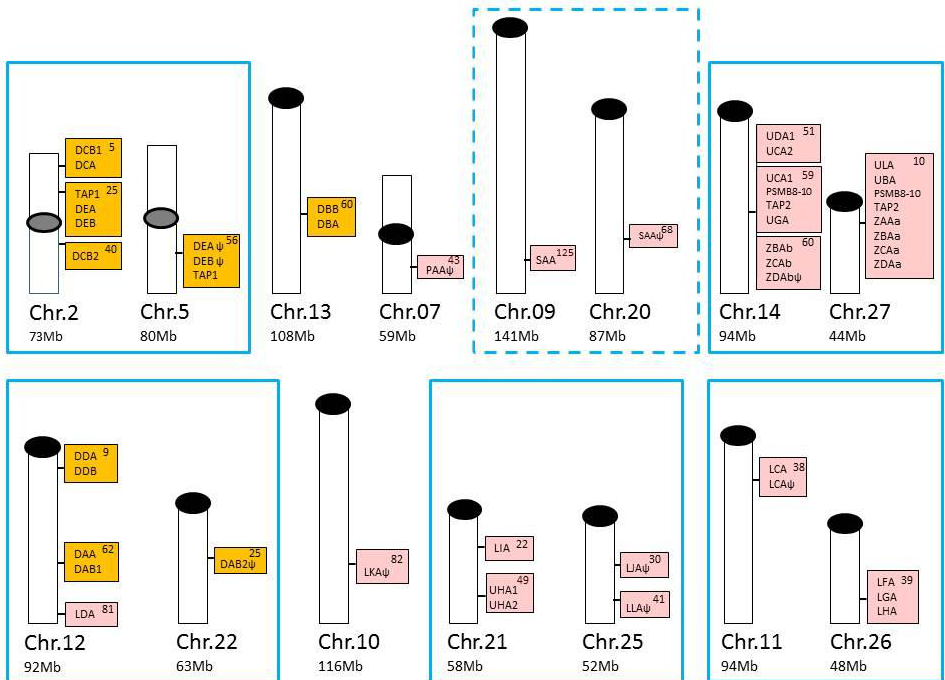
Figure 3. Chromosomal locations of Atlantic salmon major histocompatibility complex (MHC) class I and class II genes, in addition to PSMB8-10 and TAP1/2 genes based on data from [18,19]. Atlantic salmon MHC class I genes are shown with pink shading, while class II genes are shown with orange shading on individual chromosomes (NCBI genomes, GCA_000233375.4). Total size of each chromosome (Chr.) is shown below in megabases (Mb), while location of MHC genes are shown within each box. Centromeres and telomeres are shown with grey (tentative position) or black oval shapes. MHC-containing chromosomes known to be homologous or share regional homology due to the unique salmonid Ss4R WGD event [39,40] are shown with cyan boxes where the presumed shared homology between Chr.09 and 20 is tentative and thus shown using a dotted line.